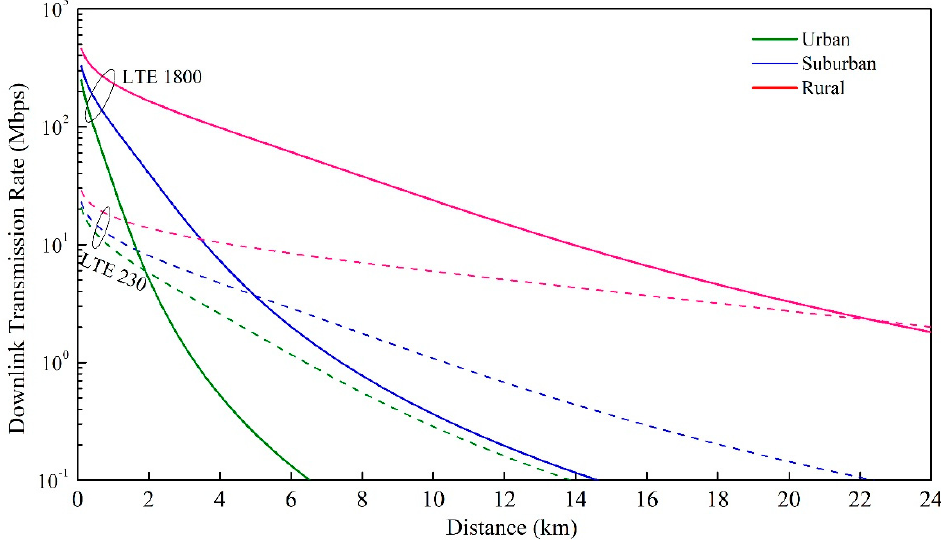
Figure 12. Downlink transmission data rate comparisons between LTE 1800 and LTE 230 in different environments.